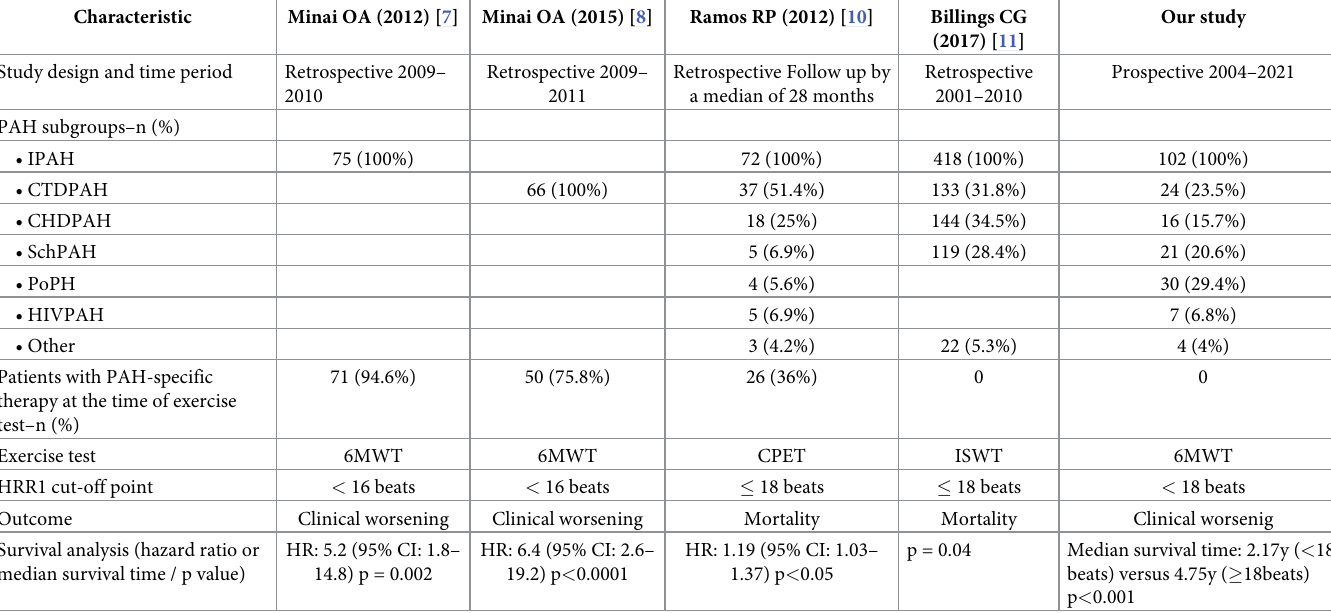
Fig 2. Event-free survival estimate of the pulmonary arterial hypertension cohort based on the HRR1 < 18 beats (n = 50) and � 18 beats (n = 52) after a long follow-up period. HRR1: heart rate recovery in 1 minute. https://doi.org/10.1371/journal.pone.0268839.g002 Table 2. Studies that investigated the association between HRR1 and clinical outcome in pulmonary arterial hypertension